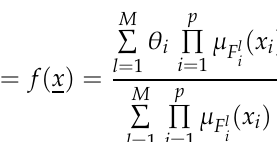
Figure 4. The seven memberships of symmetrical Gaussian functions.